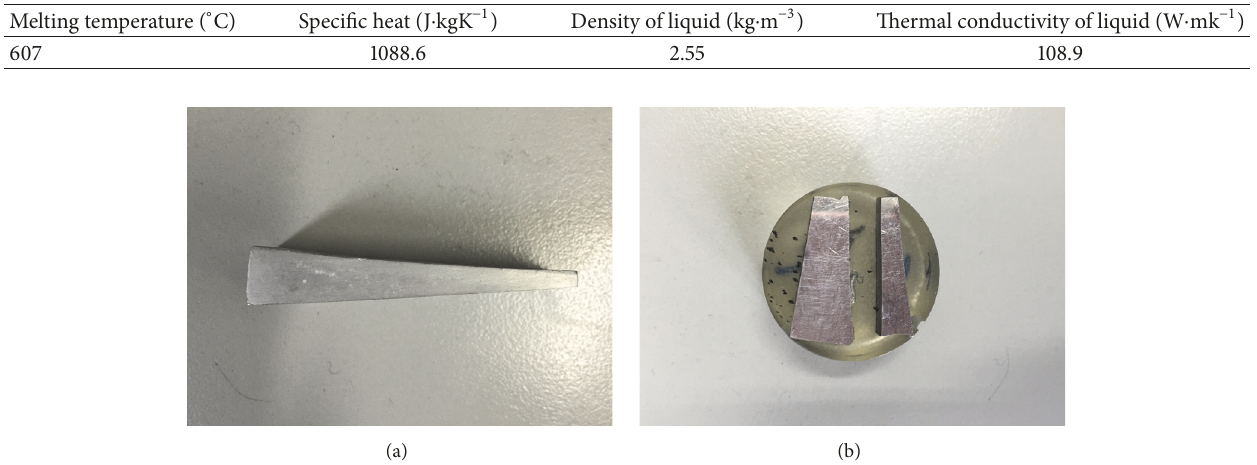
Figure 1: Twin-roll cast Al-10Mg alloy wedge-shaped plate specimen: (a) wedge-shaped plate; (b) mounting specimen.